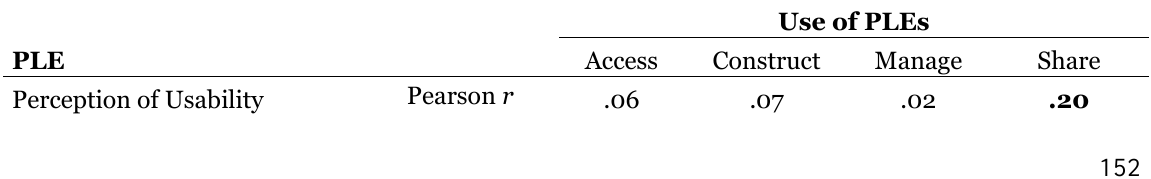
Table 4 Correlation among Perceptions of PLEs and use of PLEs (N = 109)